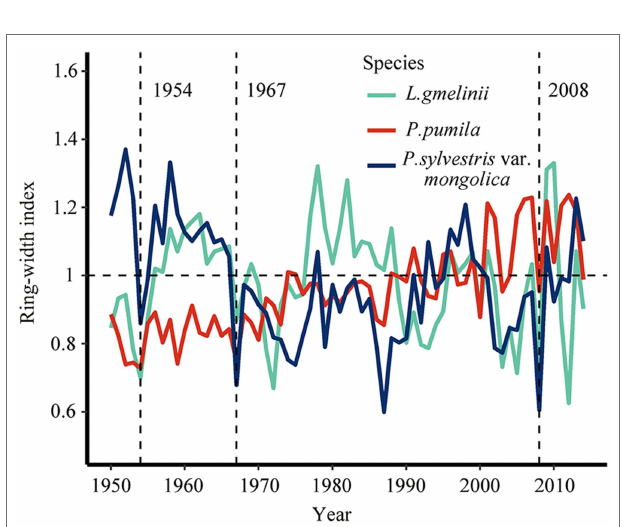
FIGURE 3 | Changes in the ring-width index of Larix gmelinii (green line), Pinus pumila (red line), and Pinus sylvestris var. mongolica (blue line) in northeast China, the vertical dash lines represent drought years (1954, 1967, and